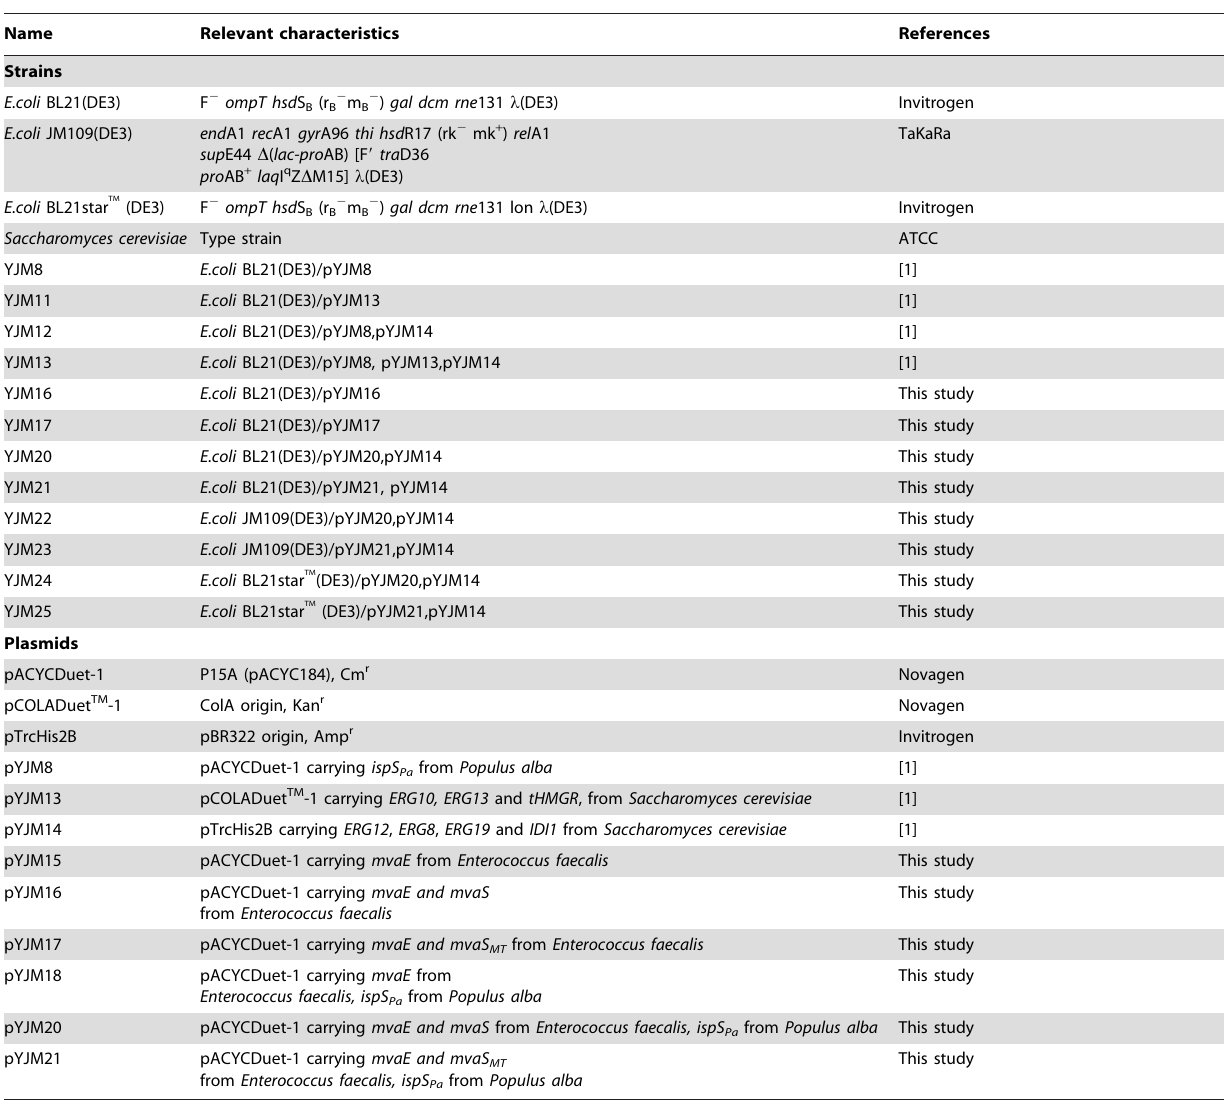
Table 1. Strains, plasmids and Oligonucleotide primers used in this